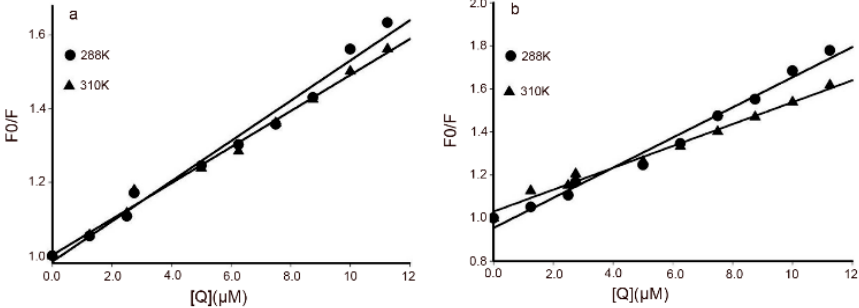
Figure 3. Stern–Volmer plots for BSA with ( a ) DPPCAH and ( b ) DPPCAH-Cu at 303 K and 310 K.